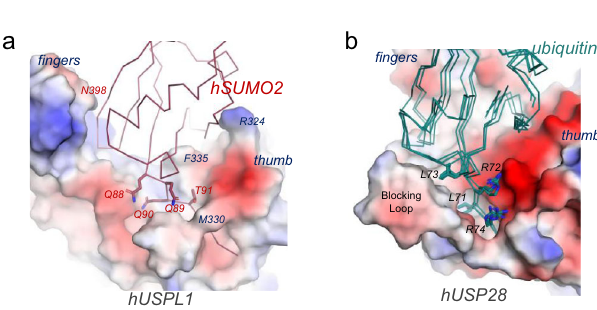
Fig. 7 Comparison of the C-terminal tails of SUMO2 and ubiquitin. a Electrostatic potential surface representation for the USPL1 in complex with SUMO2 (red line). The C-terminal tail of SUMO (QQQTGG) is labeled and shown in stick representation. Main interface contacts of thumb and fi ngers subdomains are labeled. b Electrostatic potential surface representation for the USP28 (PDB code 6HEK) in complex with ubiquitin (green lines) from complexes with USP2 (PDB code 2hd5), USP7 (PDB code 5JTV), and USP30 (PDB code 5OHK) 35,46 – 48 . The C-terminal tail of ubiquitin (LRLRGG) is labeled and shown in stick